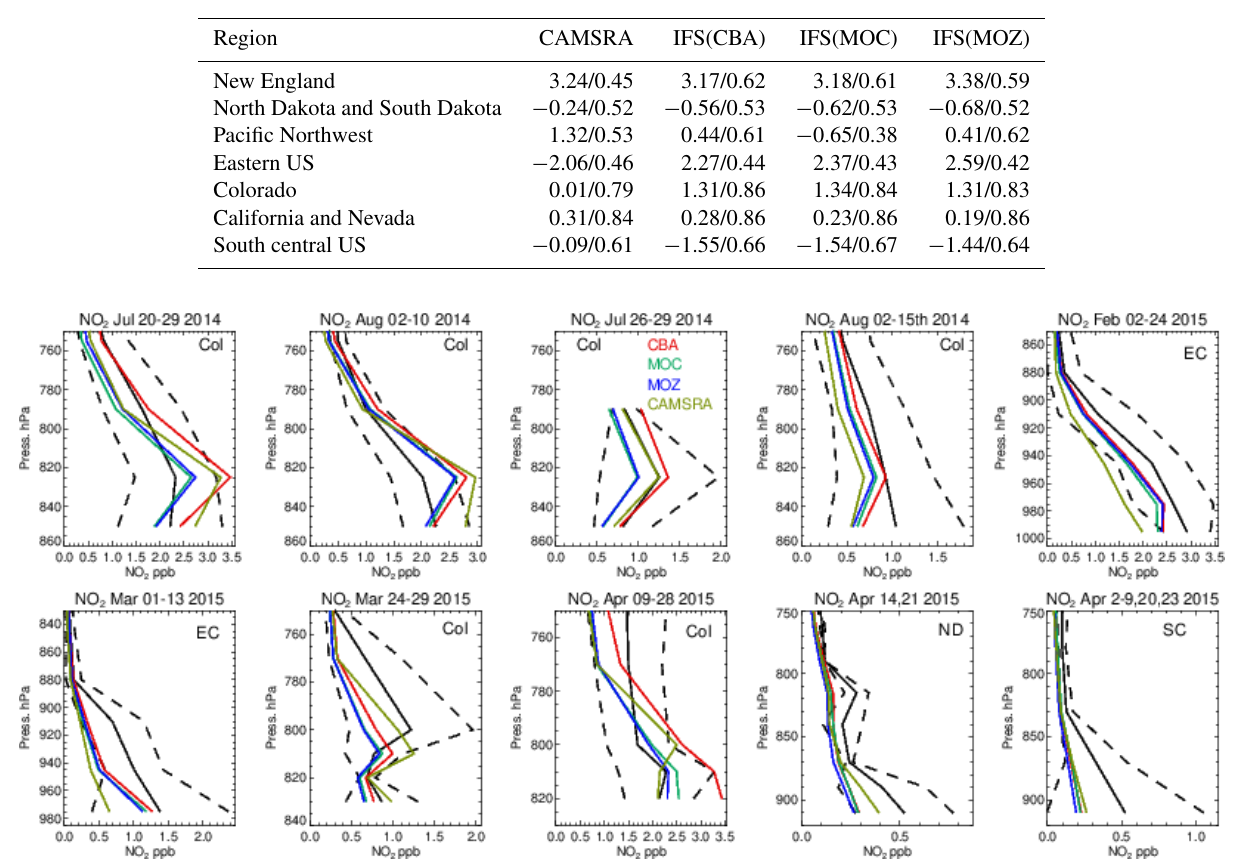
Figure 14. The same as for Fig. 6, but for tropospheric NO 2 . Campaigns shown (top left to bottom right) are DISCOVER-AQ, FRAPPE, WINTER and